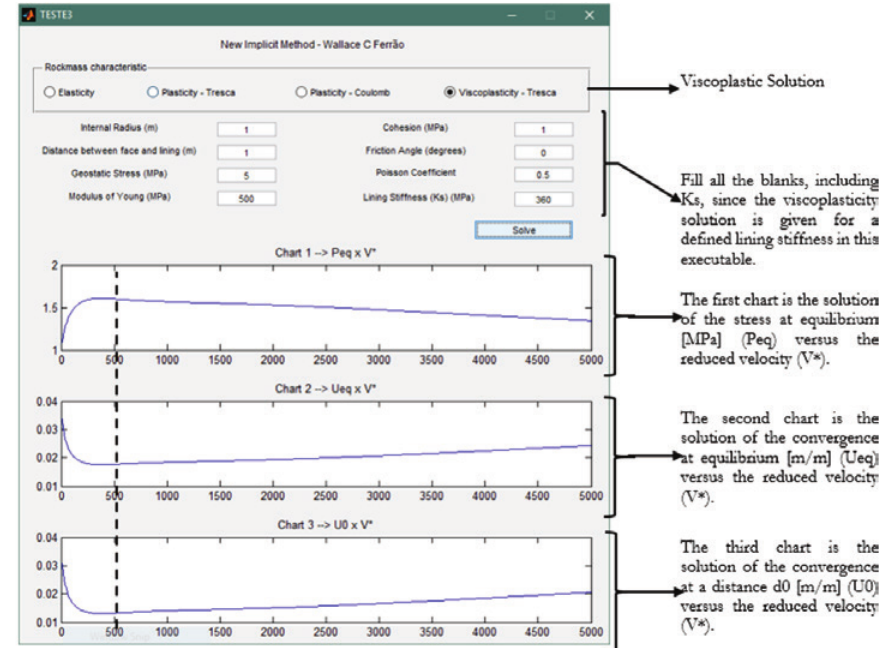
Solution for a viscoplastic rockmass through .gui